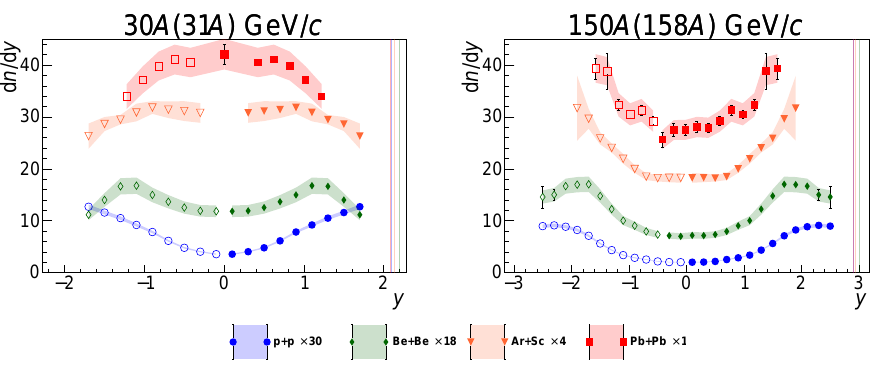
Figure 3: Rapidity spectra of protons produced in inelastic p + p and central Be + Be, Ar + Sc (preliminary) and Pb + Pb (preliminary for 30 A GeV / c ) collisions at 30 A (31 A ) GeV / c ( left ) and 150 A (158 A ) GeV / c ( right